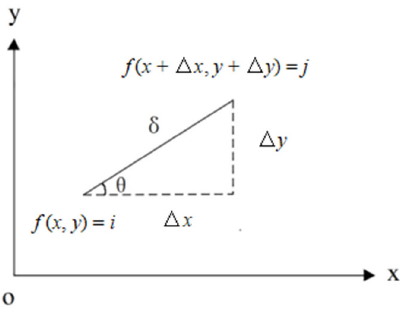
Figure 5. Generation principle of the gray-level co-occurrence matrix.